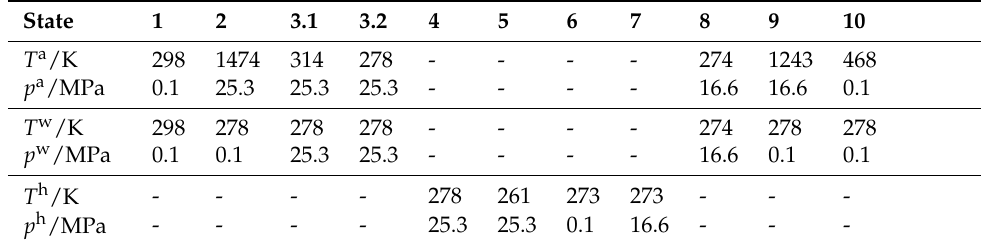
Table 2. States for the reference case.